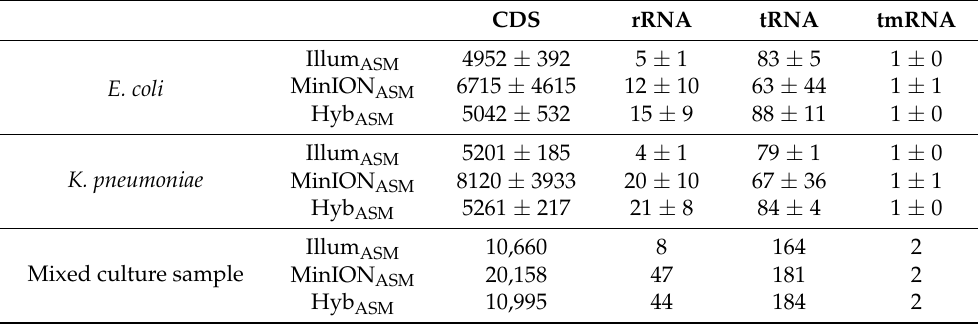
Table 3. Average values for annotating the genomic features of different assemblies from mono- cultures and mixed cultures of E. coli and K. pneumoniae isolates. Illum ASM was produced using Unicycler, MinION ASM using Flye and Hyb ASM was created using Unicycler. The mixed culture was obtained from the co-culturing of E. coli 4 and K. pneumoniae 5 isolates. Numbers show the average ± SD. CDS rRNA tRNA tmRNA Illum ASM 4952 ± 392 5 ± 1 83 ± 5 1 ± 0 MinION ASM 6715 ± 4615 12 ± 10 63 ± 44 1 ± 1 E. coli Hyb ASM 5042 ± 532 15 ± 9 88 ± 11 Illum ASM 5201 ± 185 K. pneumoniae MinION ASM Illum ASM 10,660 8 164 2 Mixed culture sample MinION ASM